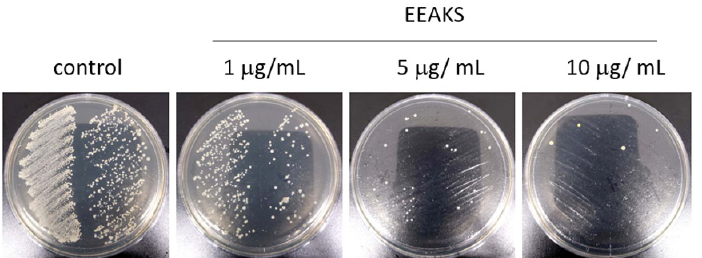
Figure 1. EEAKSs suppress Porphyromonas gingivalis growth. The effect of EEAKSs on P . gingivalis growth was investigated on Wilkins–Chalgren agar plates. P. gingivalis were cultured until optical density was approximately 0.8 (600 nm) and 10 µ L of bacterial solution was cultured on an agar plate with or without EEAKSs for 48 h in anaerobic chamber. Representative images are shown.